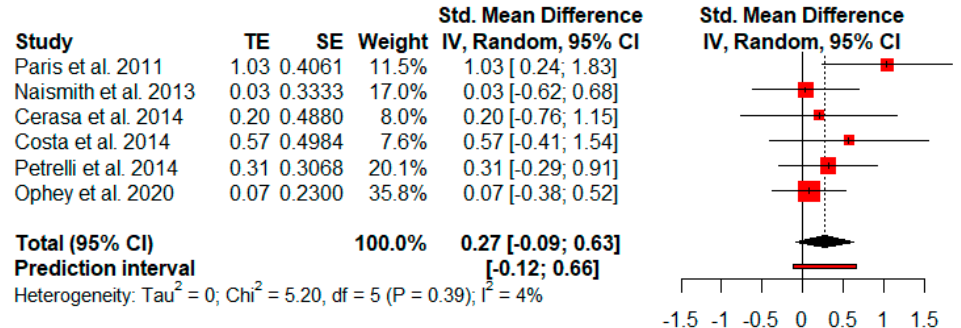
Figure 8. Effectiveness of cognitive rehabilitation in verbal fluency. Figure 8 . Effectiveness of cognitive rehabilitation in verbal fluency. Figure 8 . Effectiveness of cognitive rehabilitation in verbal fluency.